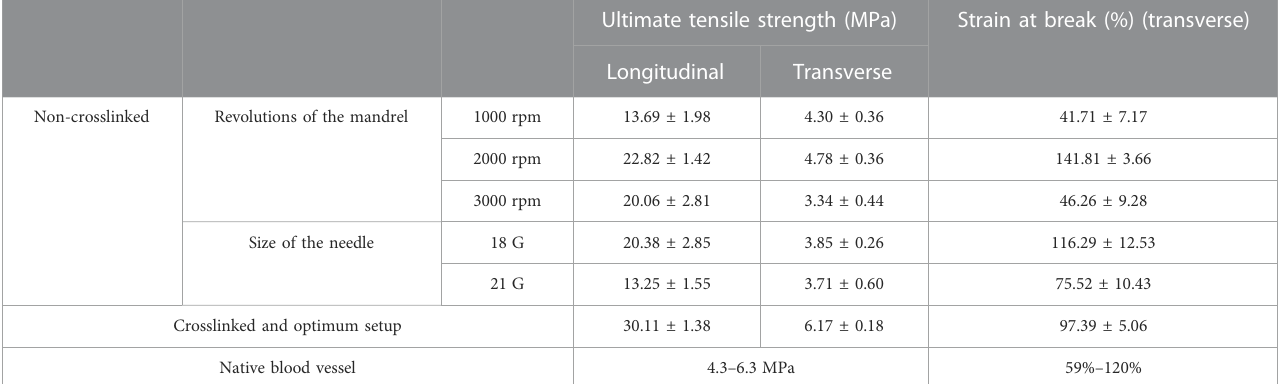
Ultimate tensile strength (MPa) Strain at break (%) (transverse) Longitudinal Transverse